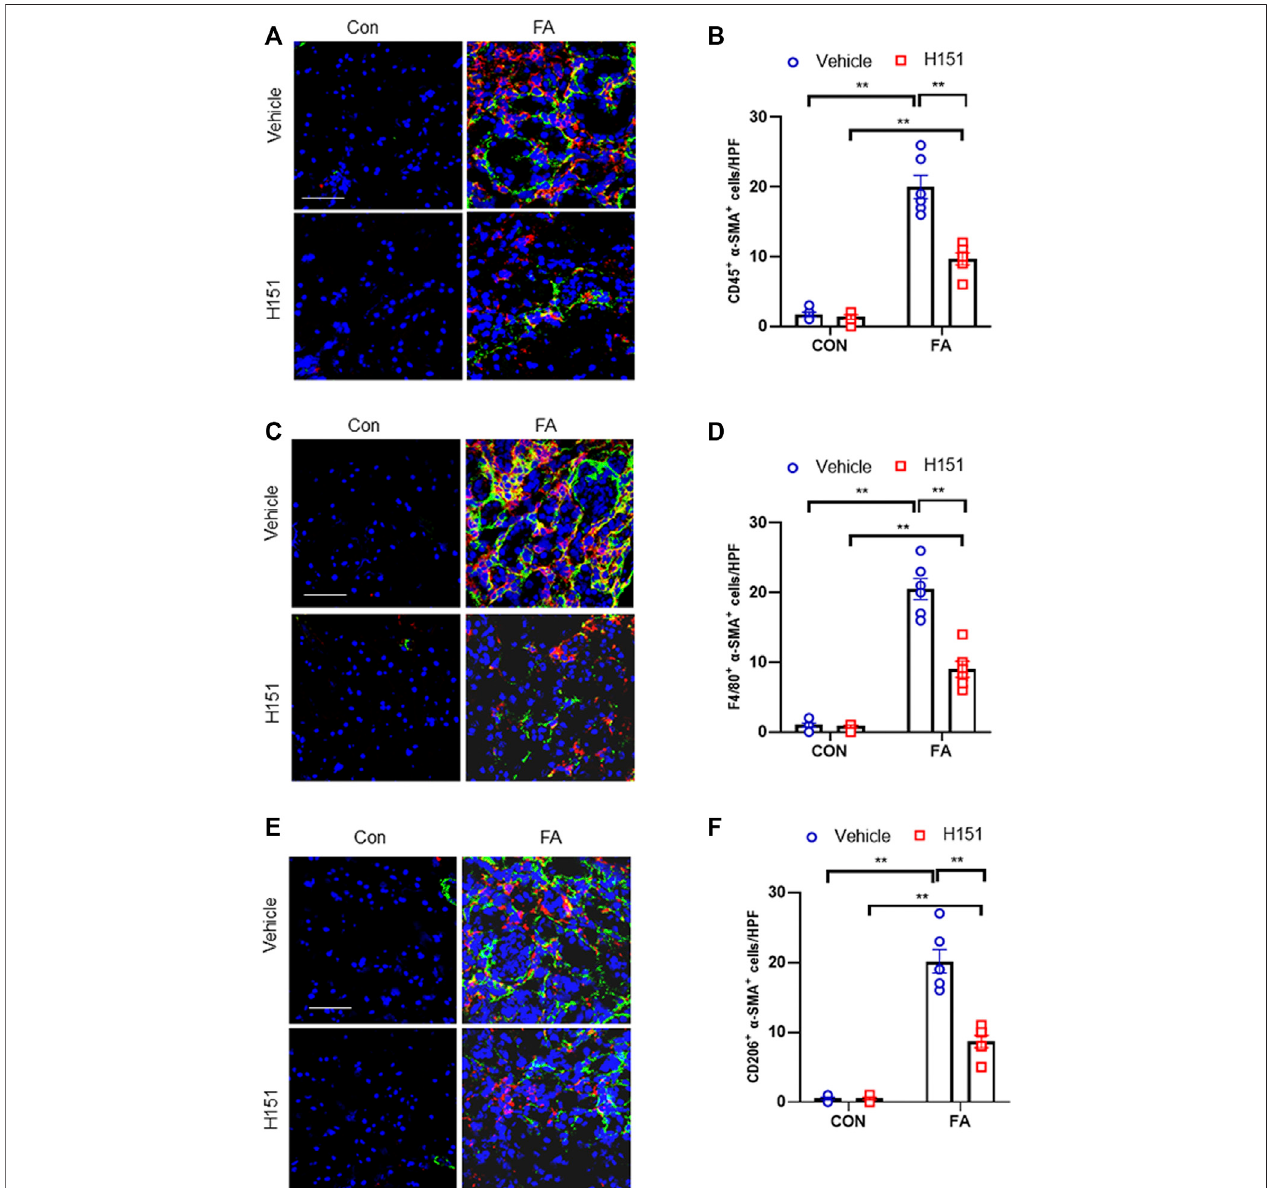
FIGURE 2 | Pharmacological inhibition of STING impaires myeloid fi broblast activation and MMT in FA nephropathy. (A) Representative immuno fl uorescence photomicrographs of kidney sections in each group stained for CD45 (red), α -SMA (green), and DAPI (blue). (B) Quantitative analysis of CD45 and α -SMA dual positive cellsinthekidneys. (C) Representativeimmuno fl uorescencephotomicrographsofkidneysectionsineachgroupstainedforF4/80(red), α -SMA(green),andDAPI(blue). (D) Quantitative analysis of F4/80 and α -SMA dual positive cells in the kidneys. (E) Representative immuno fl uorescence photomicrographs of kidney sections in each group stained for CD206 (red), α -SMA (green), and DAPI (blue). (F) Quantitative analysis of CD206 and α -SMA dual positive cells in the kidneys. ** p < 0.01; n = 6 in each group; Scale bar: 50 μ m.